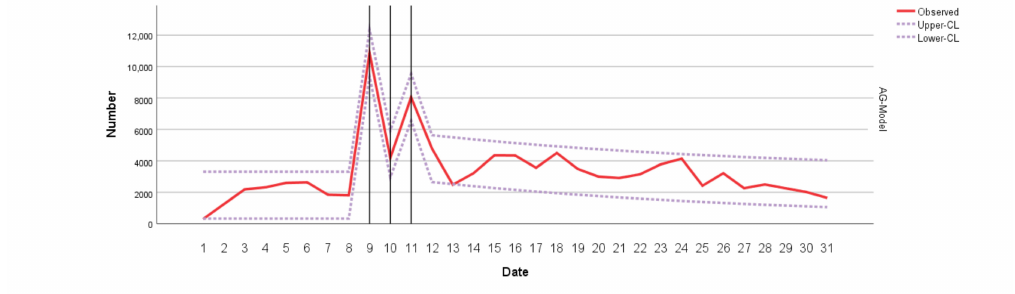
Figure 1. ARIMA time series models of Western Balkan Refugee Crises 2015 / 2016: ( a ) number of refugees’ arrivals in Serbia (Model A); ( b ) number of refugees’ arrivals in the Europe Union (Model B); ( c ) number of refugees registered in health care institutions of Serbia (Model C); ( d ) number of medical conditions of refugees in Serbia (Model D); and ( e ) number of health care services used by refugees in Serbia (Model E).